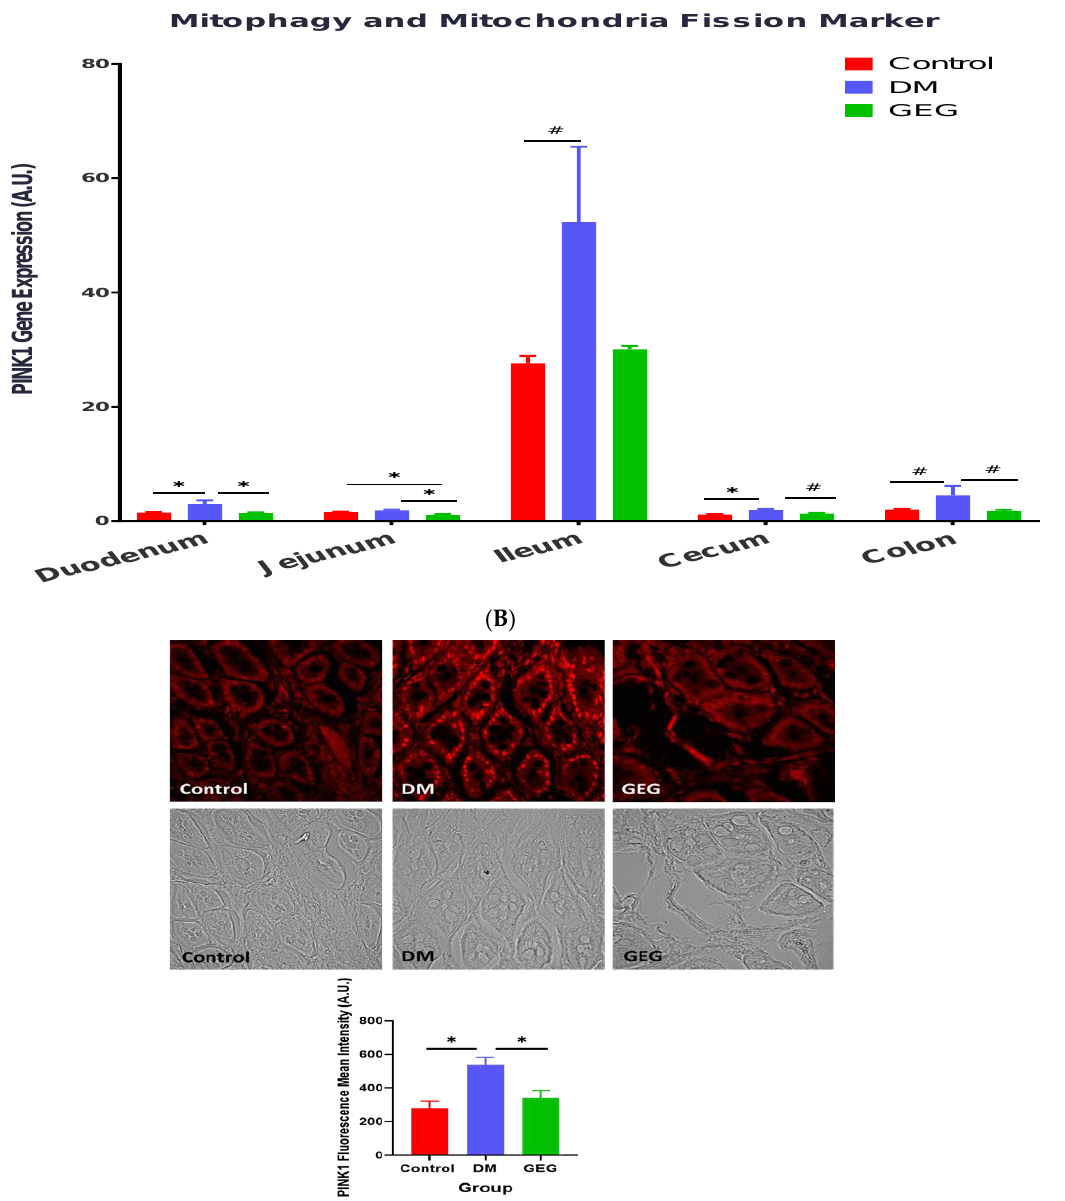
Figure 12. Effect of gingerol-enriched ginger (GEG) on mRNA gene expression of PINK1 in duode- num, jejunum, ileum, cecum, and colon of rats ( A ). Colon tissue sections were immunostained for PINK1 along with quantification of PINK1 fluorescence intensity ( B ). Data is expressed as mean ± S EM. n = 6–8 per group. Data was analyzed by one-way ANOVA followed by a post hoc Tukey’s test. * p < 0.05. # 0.05 < p < 0.1. IHC magnification 60×.